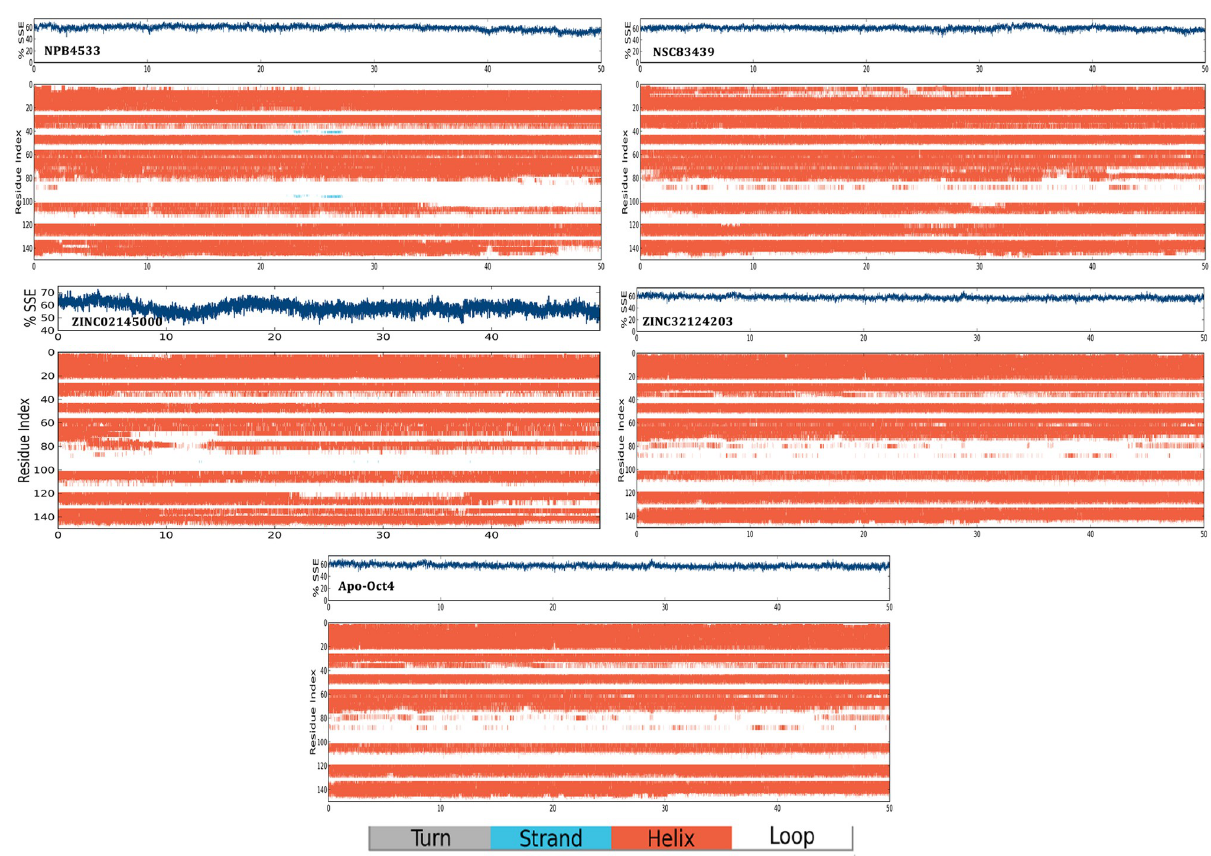
Fig 9. Time evaluation of secondary structure elements for model structure and in complex with four selected